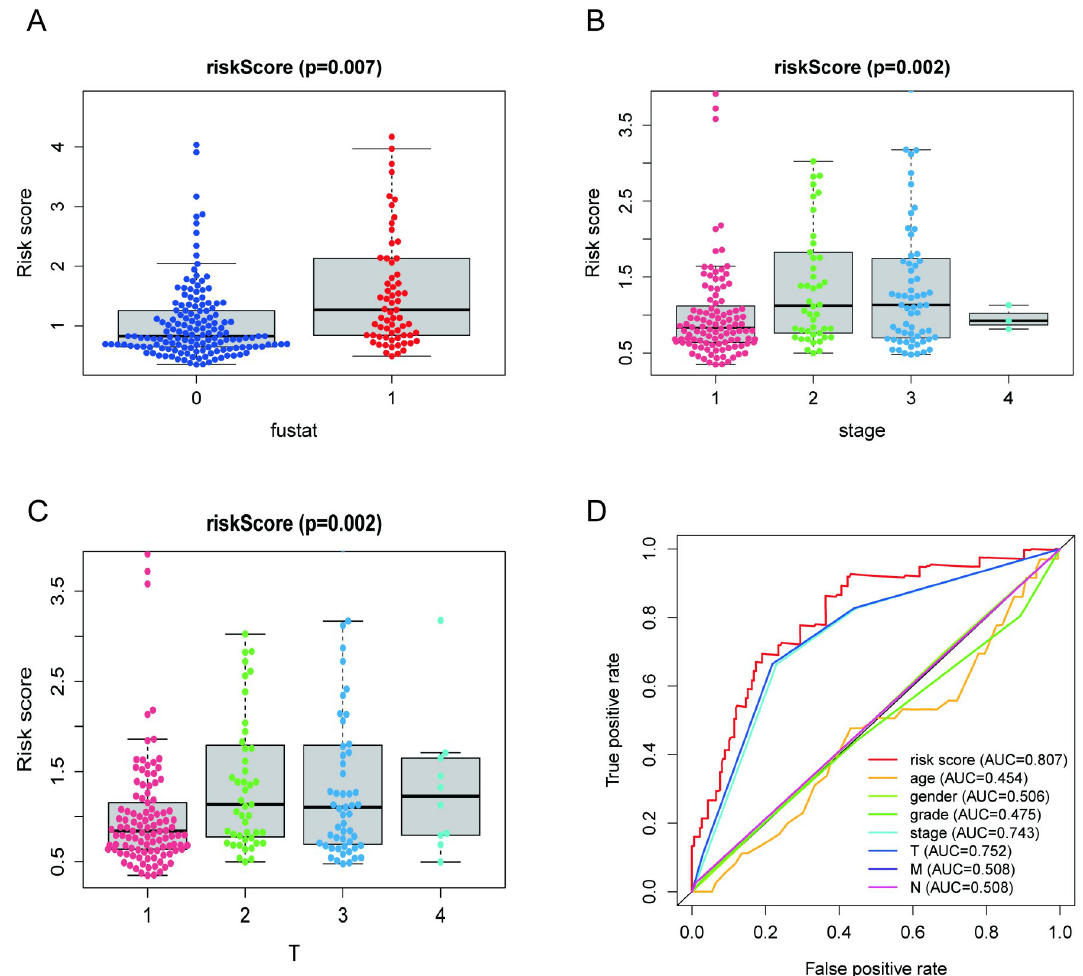
Fig 4. Clinical significance of the prognostic index. Risk score in (A) survival outcome, (B) tumor stage, (C) N stage.